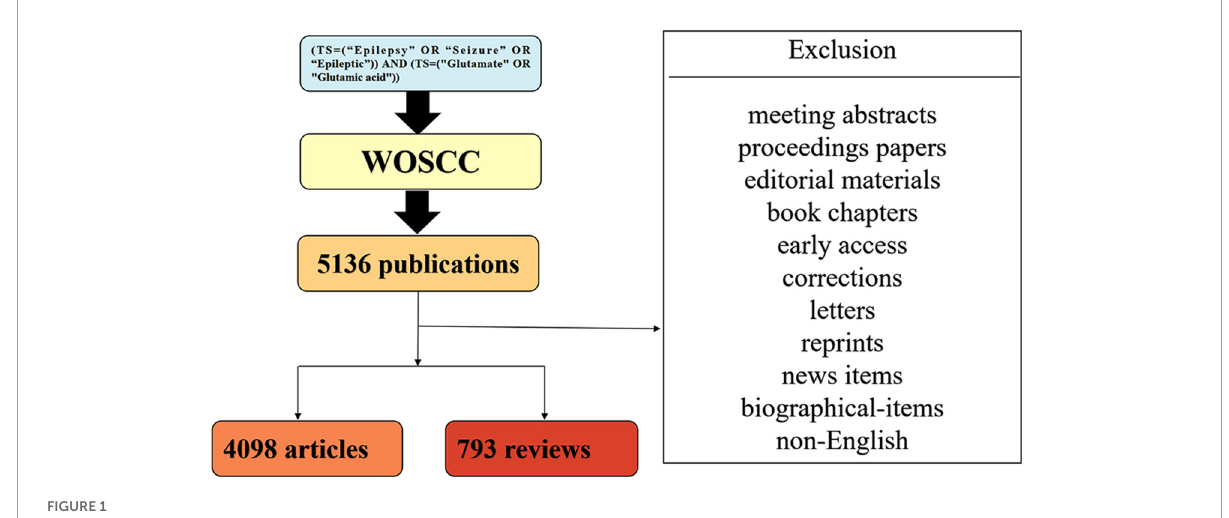
FIGURE1 Flowchart of the filtering